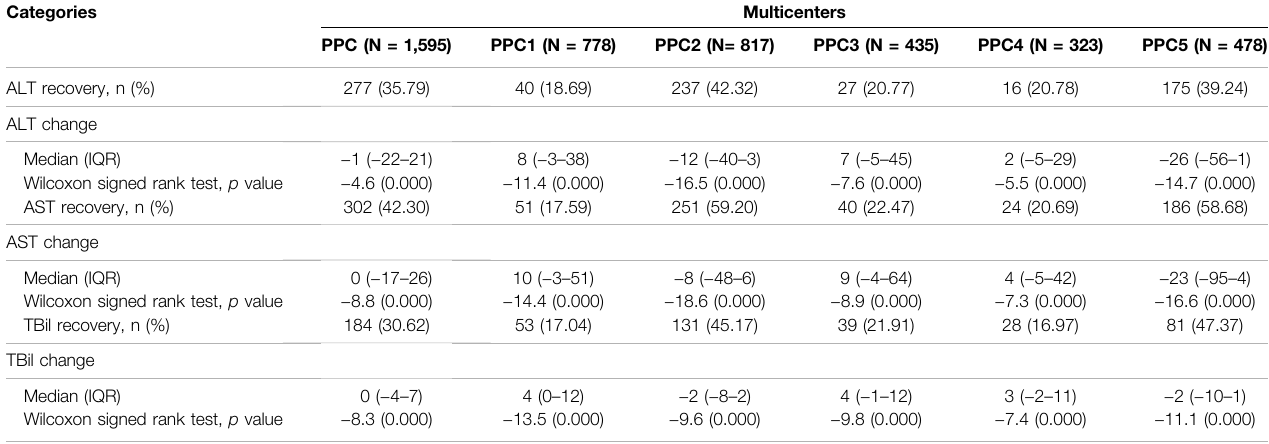
TABLE 3 | Changes of ALT/AST/TBil after PPC